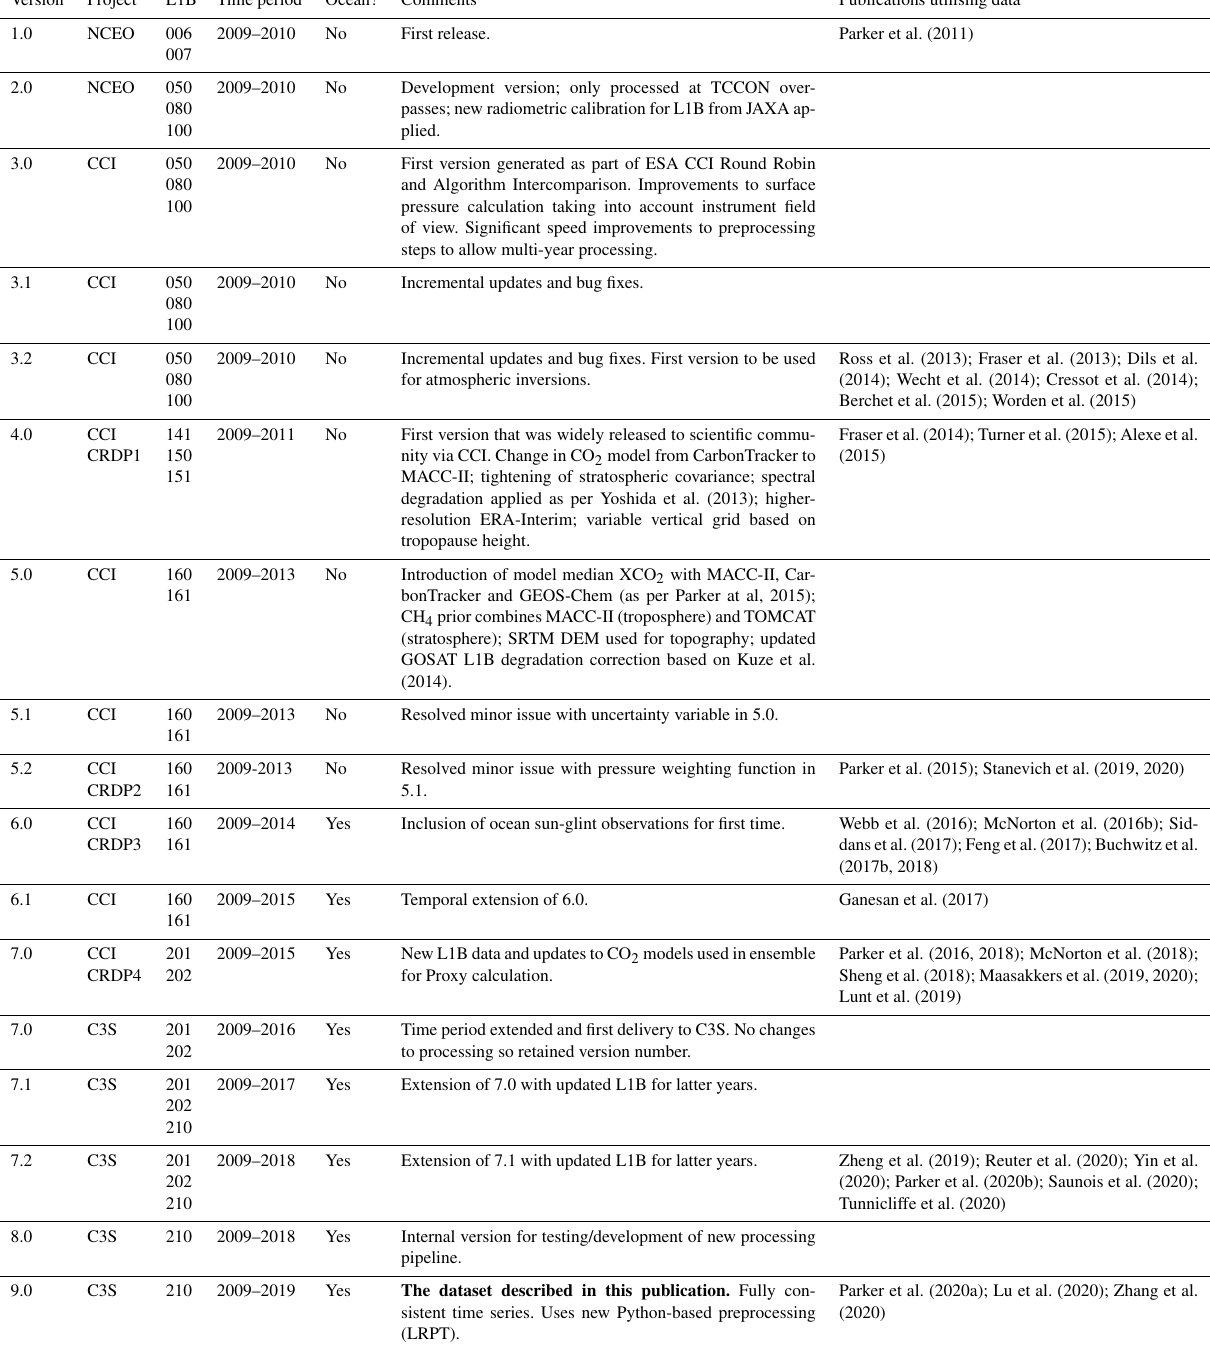
Table B1. Table showing the evolution of the University of Leicester GOSAT Proxy XCH 4 data product. Entries include the version number, the project that the data were generated for, the version of the GOSAT L1B data used, the time period covered by the data, whether ocean sun-glint data were generated, comments relating to changes/updates from previous versions and peer-reviewed publications that we are aware of that used the data. For the ESA GHG-CCI project, we also indicate which versions were officially delivered as part of the Climate Research Data Packages through the project. All Copernicus C3S versions were delivered to the Copernicus Climate Data